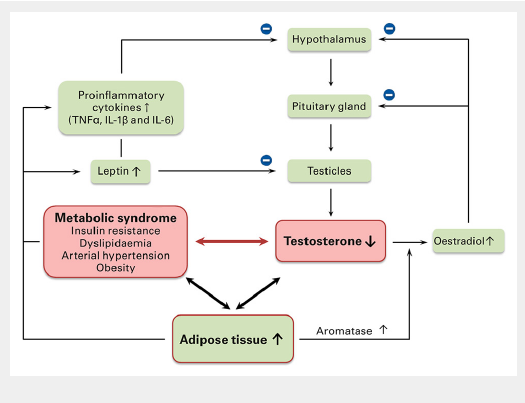
Figure 1 Pathophysiological interplay between adverse metabolic parameters, adipose tissue and testosterone deficiency. Adipose tissue as a pivotal component of the pathophysiological interplay leads to increased release of inflammatory mediators (TNF-α, IL-1β and IL-6) and leptin which cause dysfunctions of the hypothalamic-pituitary-testicular axis and result in decreased testosterone production. Increased activity of aromatase in adipose tissue enhances the conversion of testosterone to oestradiol which exerts negative feedback effects on both hypothalamus and pituitary gland. Consecutive testosterone deficiency promotes an increase in fat mass and worsening of metabolic surrogate parameters, demonstrating the bidirectional relationship.